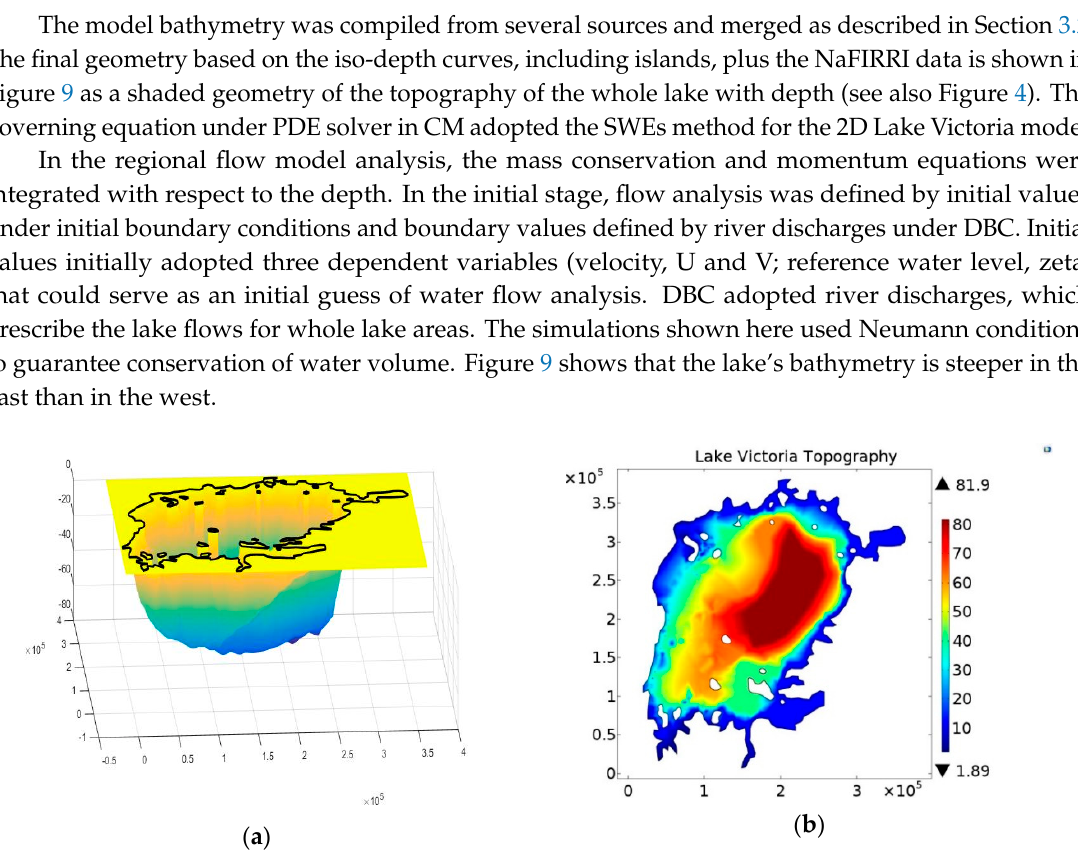
Figure 9. Lake Victoria water depths based on iso-depth curves and NaFIRRI bathymetry data: ( a ) Matlab model; ( b ) Comsol model.